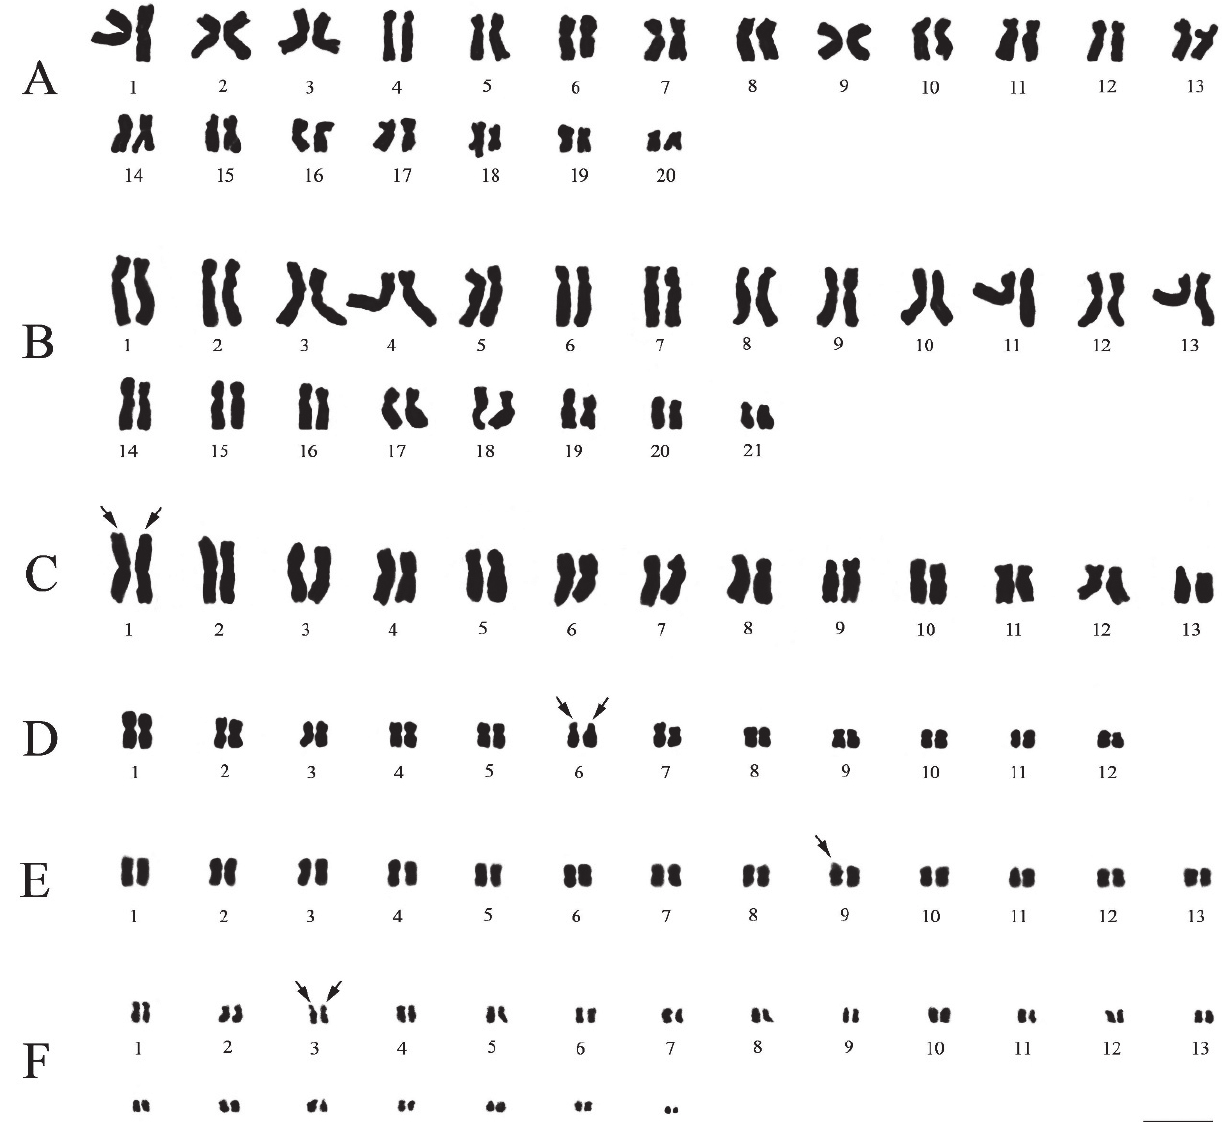
Figure 2. Karyotypes by conventional staining. Ag. modestum (A) , Ag. simplex (B) , Am. serrulatus (C) , Ar. maxwellii (D) , Ha. benthamiana (E) and Ho. griffithii (F) . Arrows in C-F indicate satellite. Scale bar = 10 µ